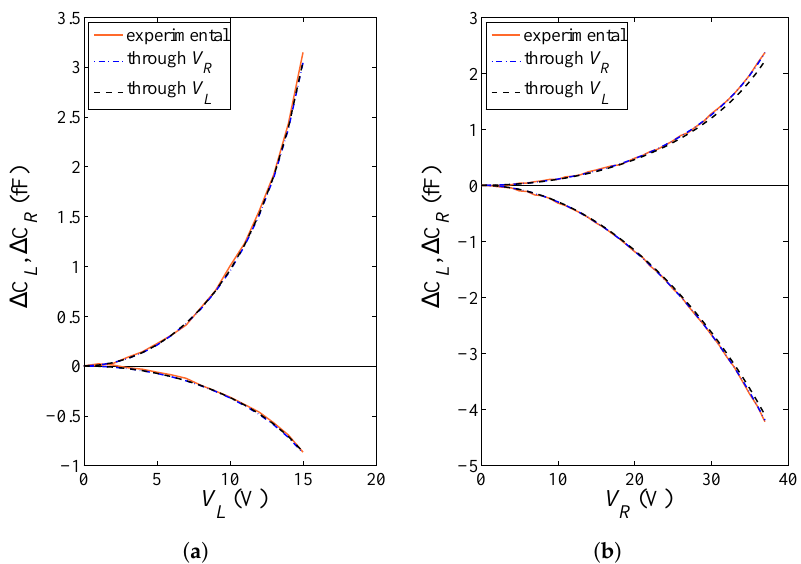
Figure 7. Specimen #9: capacitance change values ∆ C L and ∆ C R under ( a ) lateral actuation through V L and ( b ) rotational actuation through V R . Comparison between the experimentally measured response, and the theoretical solution with model parameters tuned by the GA under either lateral or rotational